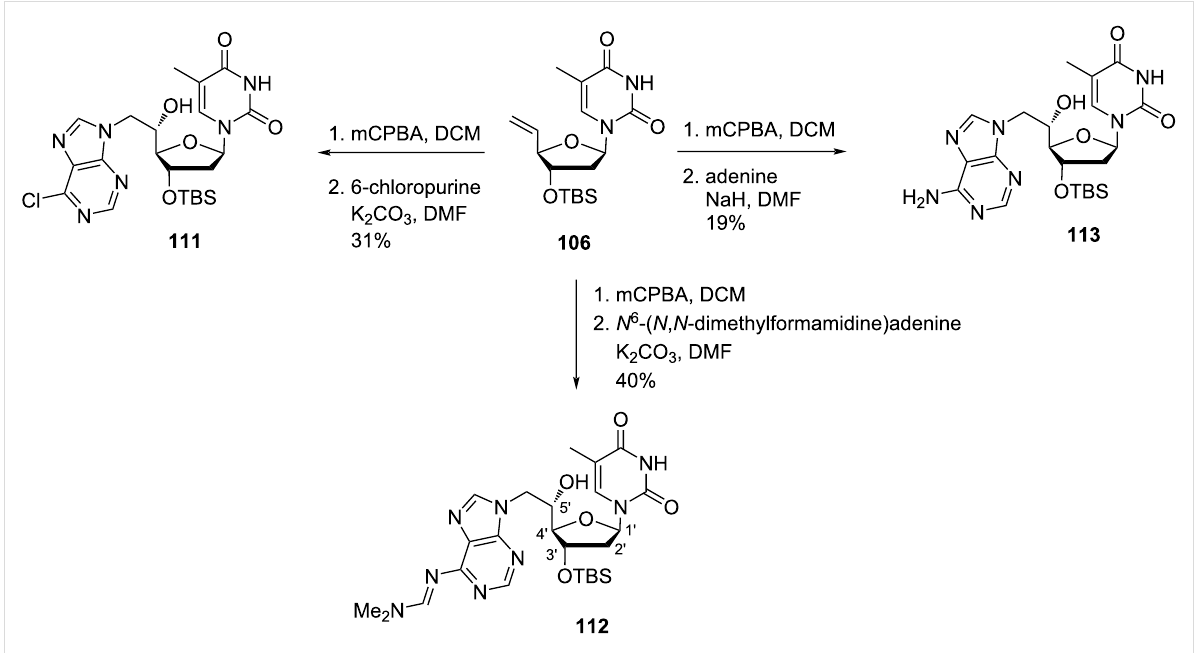
where a triazole linker connected the additional thymine to the 5 ′ -position of thymidine (Scheme 27)